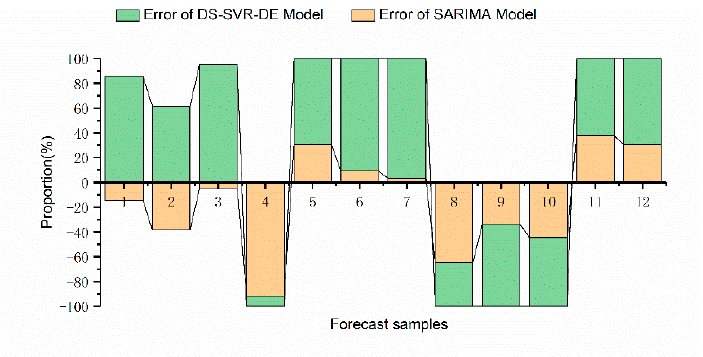
Figure 10. A comparison of short-term prediction errors between the proposed DS-SVR model and the SARIMA model in the medium-sized type.